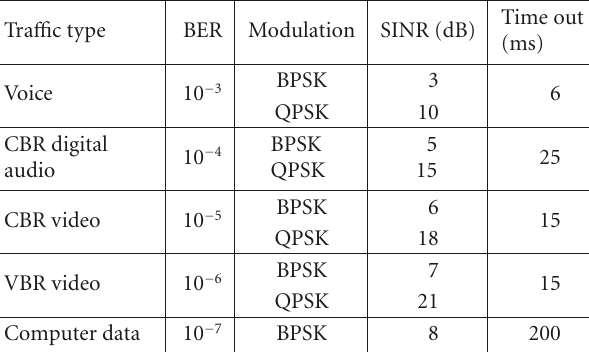
Table 3: Multimedia QoS requirements.